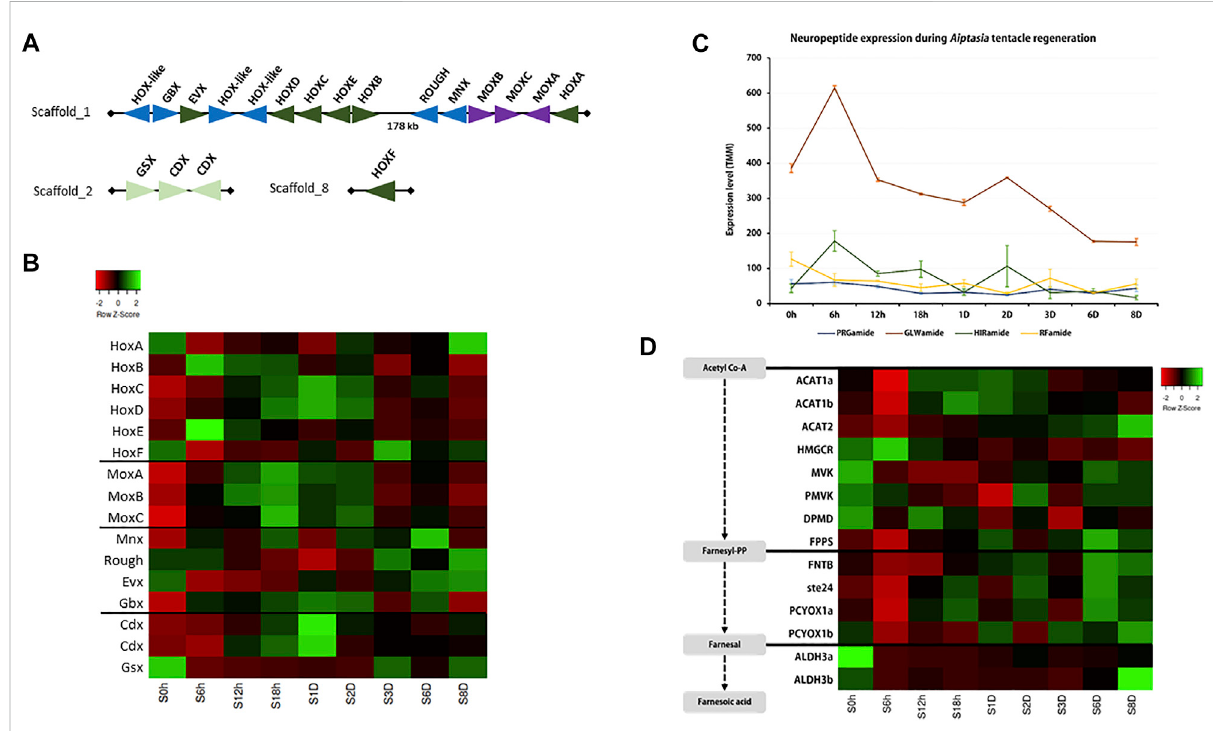
FIGURE 5 (A) Hox and other homeobox gene arrangement in the Exaiptasia pallida genome; (B – D) Expression of (B) Hox genes, (C) neuropeptides, and (D) sesquiterpenoid hormone pathway genes during tentacle